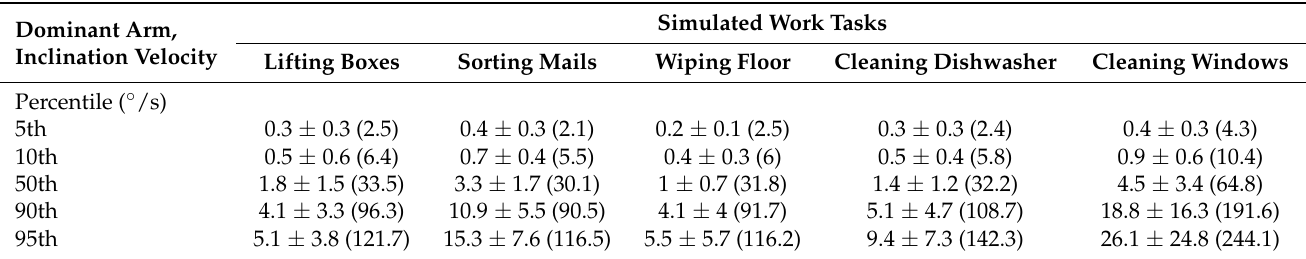
Table 3. The mean ± standard deviation of the mean absolute errors (MAEs) of the dominant upper arm inclination velocity between cloth sensors and skin sensors during the five simulated tasks, with the reference value of skin sensors shown in brackets ( n =